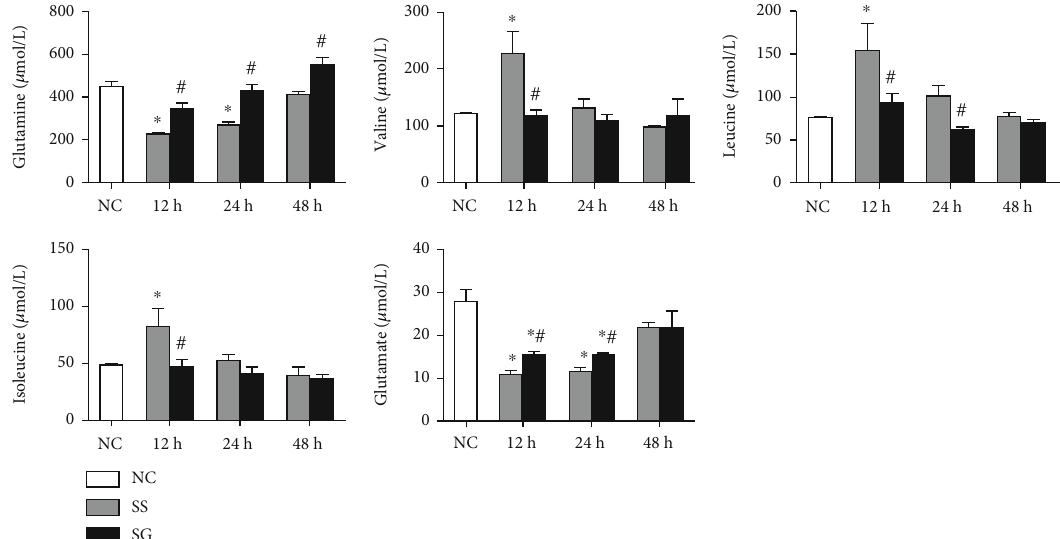
Figure 1: Plasma amino acid concentrations in the normal control (NC) and the sepsis groups at di ff erent time points. SS: sepsis group with saline; SG: sepsis group with glutamine. Values are expressed as the mean ± SEM . All data are representative of duplicate measurements at 12, 24, and 48 h after cecal ligation and puncture (CLP) ( n = 8 for each respective group). Di ff erences between 2 sepsis groups at the same time point were analyzed by t -test. The comparison among NC and the sepsis groups at three di ff erent time points were analyzed by a one-way analysis of variance (ANOVA) followed by Tukey ’ s post hoc test. ∗ Signi fi cantly di ff ers from the NC group; # signi fi cantly di ff ers from the SS group at the same time point ( p < 0 : 05 ).